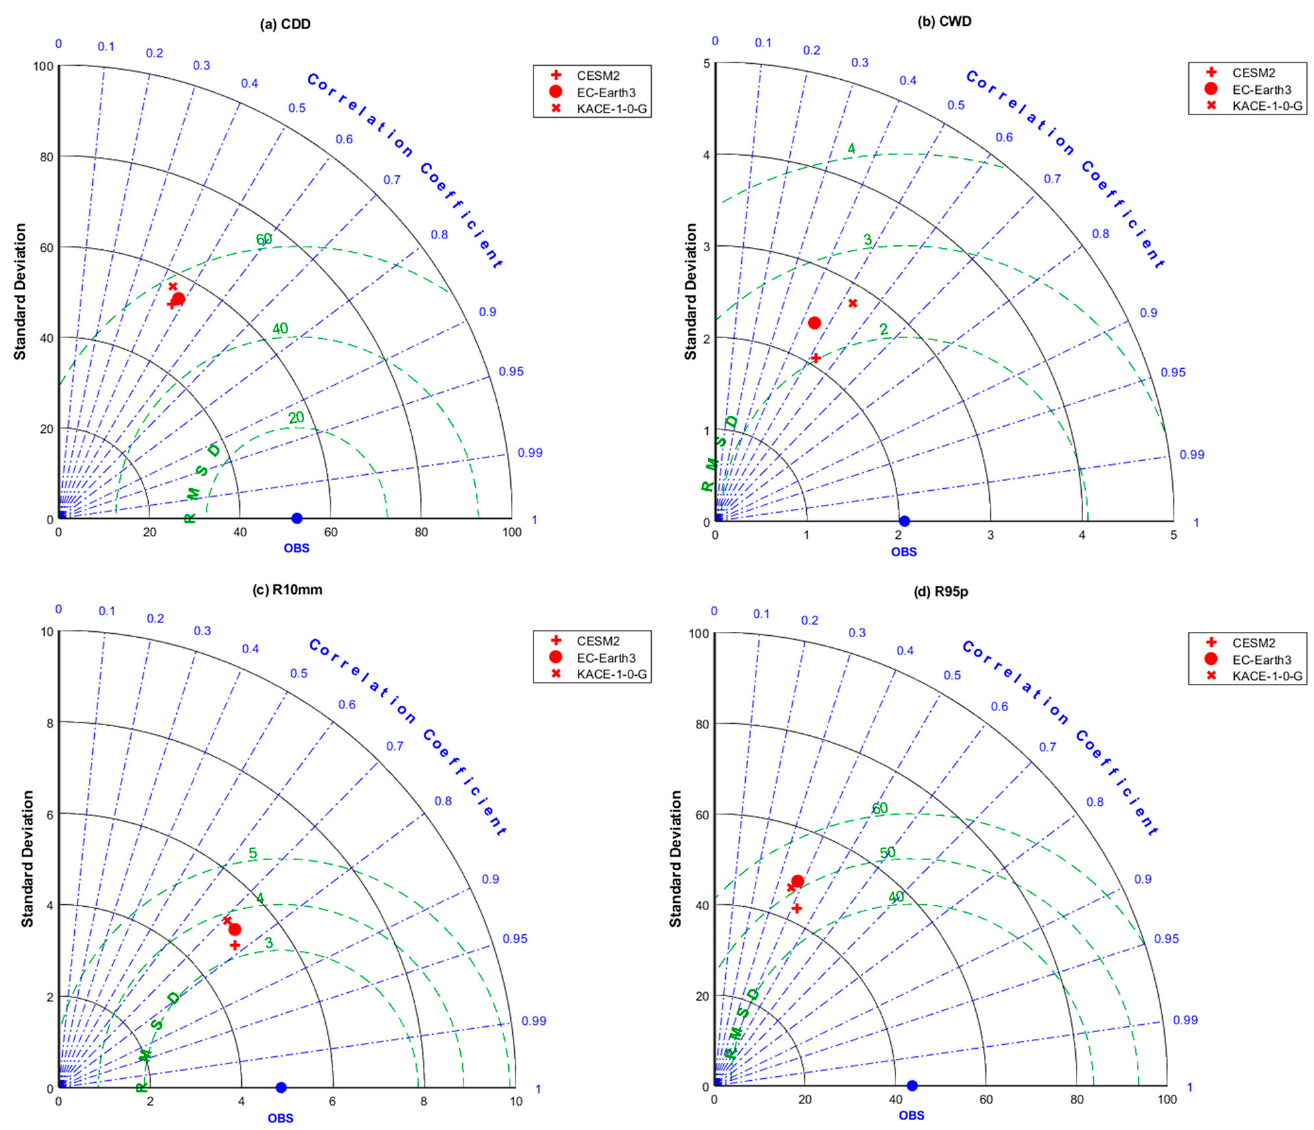
Figure 4. Taylor diagrams indicating correlation coefficients, standard deviation, and RMSE of CDD, CWD, R10mm, and R95p from 1970 to 2014. Table 4. Statistical errors of the eight extreme precipitation indices between the corrected CMIP6 models and the observed values. (* represents the corrected CMIP6